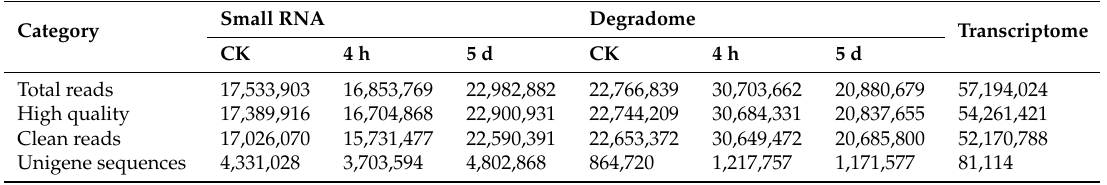
Table 1. Dataset summary of sequencing of small RNA, degradome and transcriptome libraries. Small RNA Category